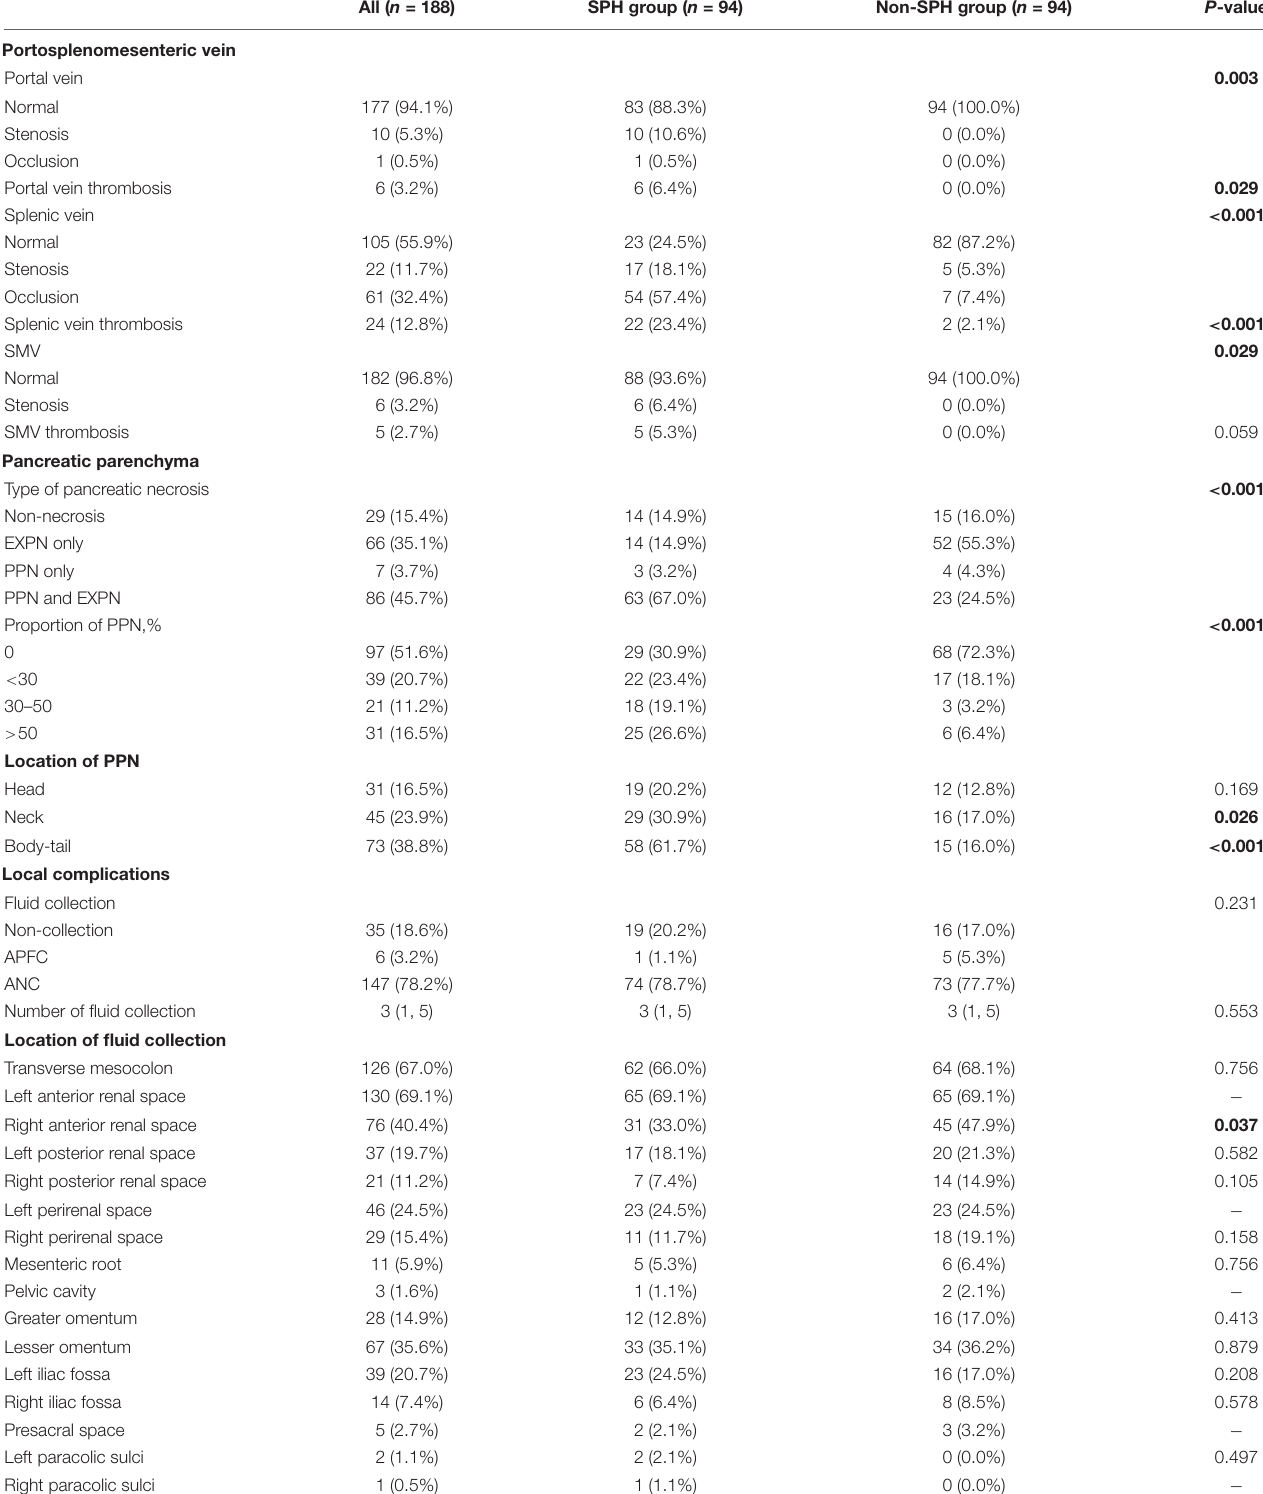
TABLE 2 | Imaging features on CECT within 2 weeks of AP